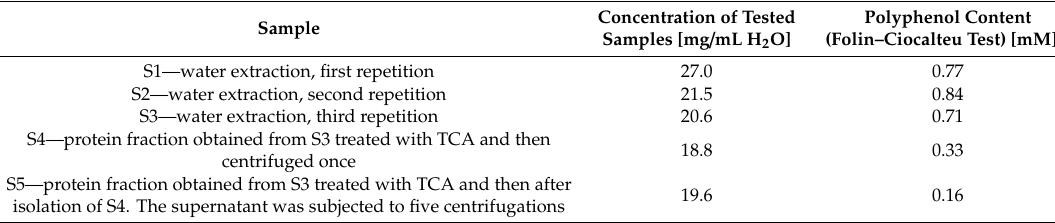
Table 1. Summary of Lowry test results and total polyphenol